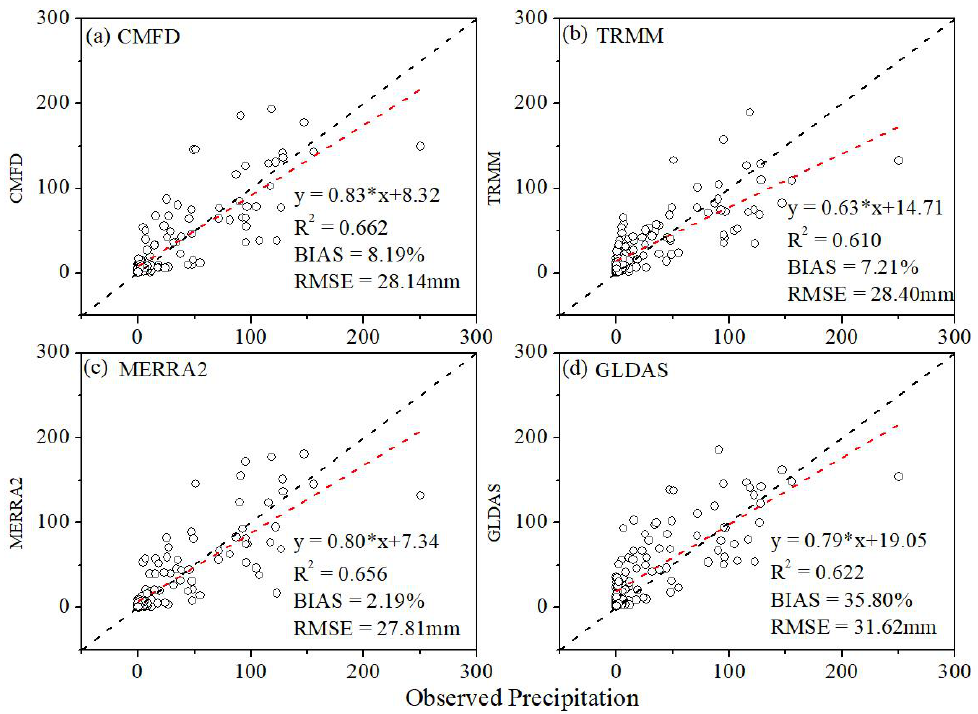
Figure 2. Comparison of monthly ( a ) China Meteorological Forcing Data (CMFD), ( b ) Tropical Rainfall Measuring Mission (TRMM), ( c ) Modern-Era Retrospective analysis for Research and Applications version 2 (MERRA2), and ( d ) Global Land Data Assimilation System (GLDAS) precipitation products with the observed precipitation at the Nam Co Monitoring and Research Station for Multisphere Interactions from 2005 to 2015. The black dotted line (“y = x, 1:1”) and the red dotted line (linear fitting) are given for reference.